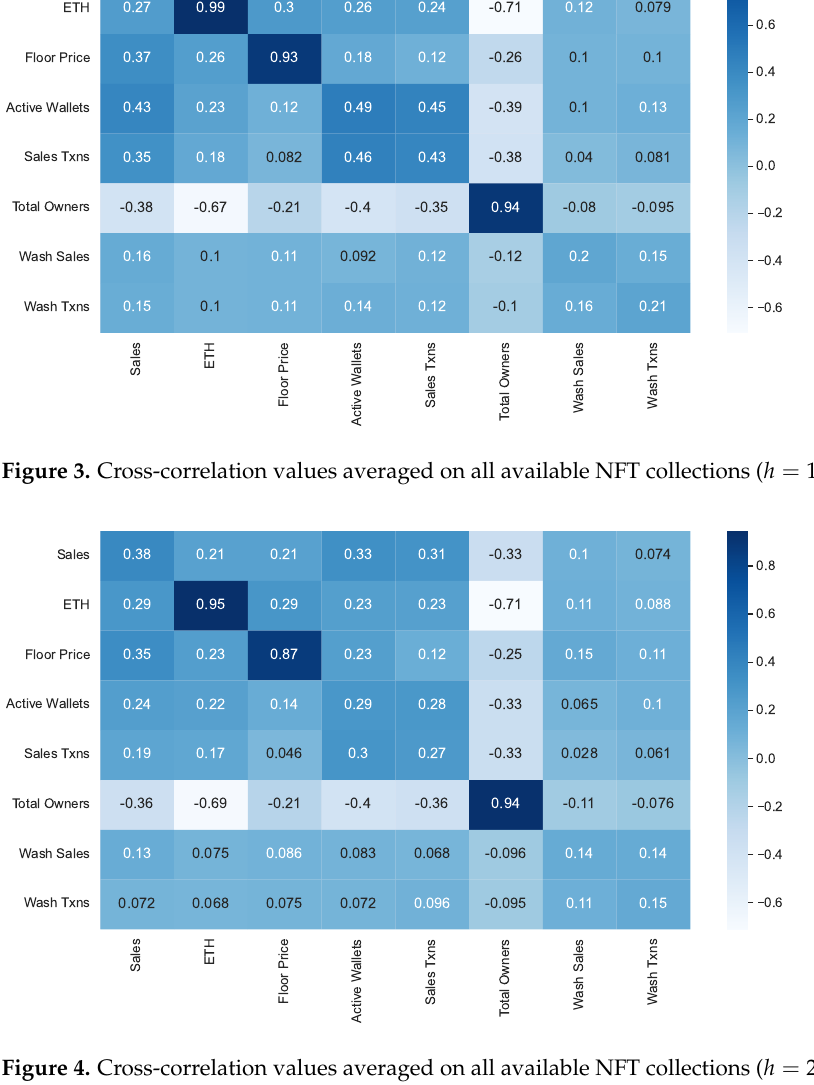
Figure 4. Cross-correlation values averaged on all available NFT collections ( h =